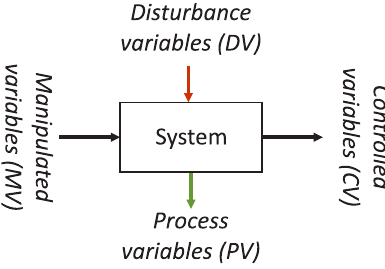
Figure 3. Principal sketch for a system in a real-life